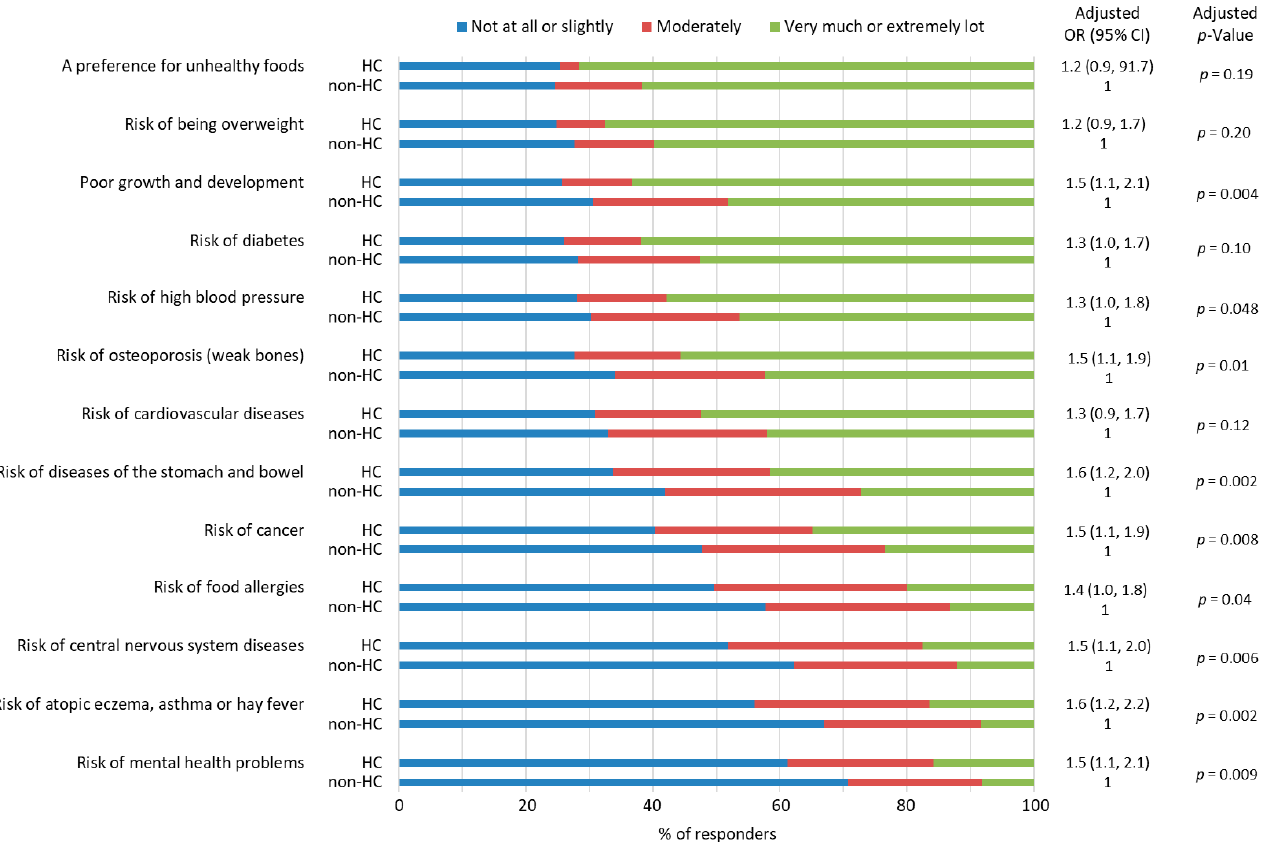
Figure 2. Health-conscious (HC) and non-health-conscious (non-HC) parents´ views on the extent to which childhood diet influences long-term health and specific diseases and conditions. Associa- tions between parents’ views and parental health consciousness were examined by ordinal logistic regression analyses after adjustment for the parents’ gender, education, and whether the parent had a degree in a field of health or nutrition. Missing data n = 20–49 depending on the question. OR = odds ratio, CI = confidence interval.